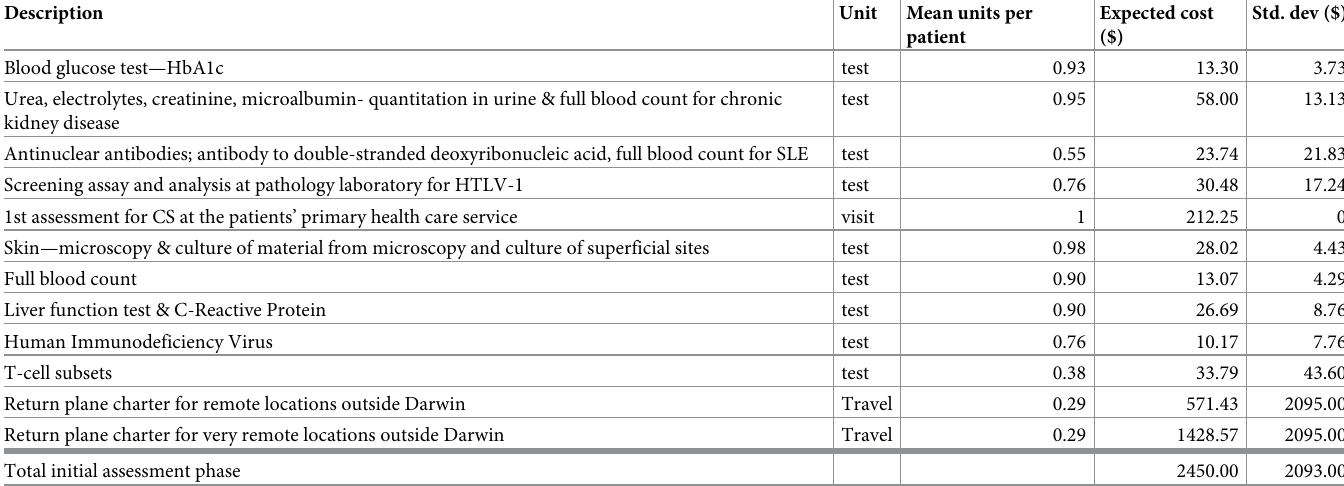
Table 4. Resource use and expected cost of the CS initial assessment